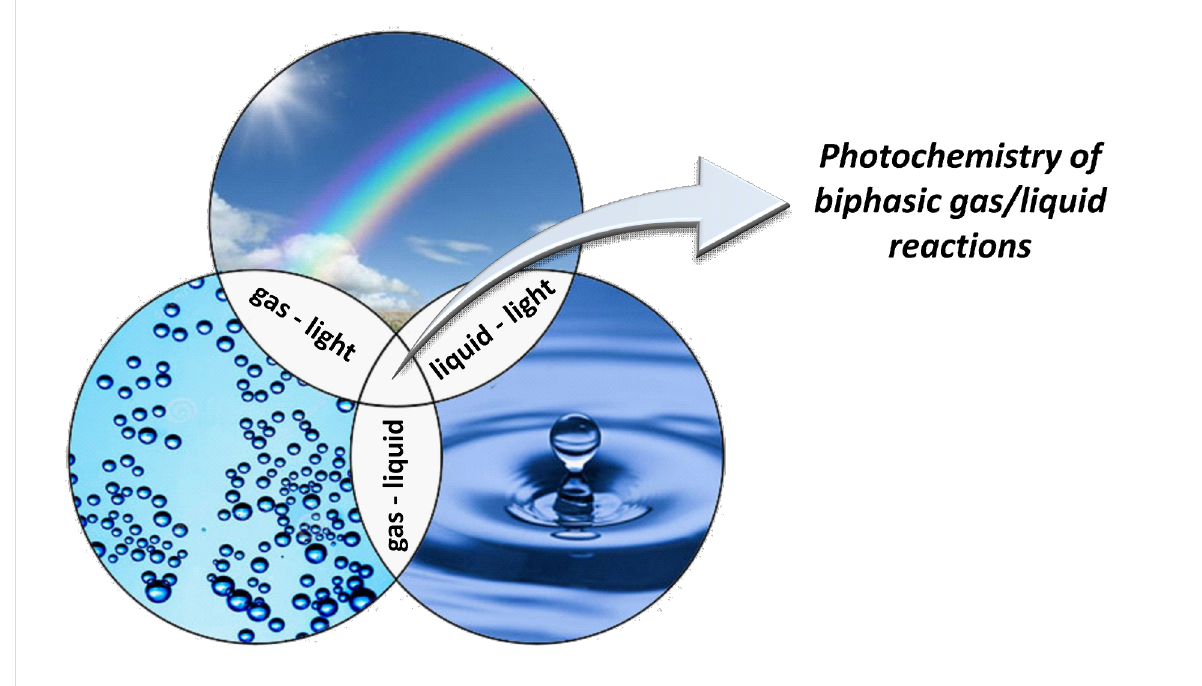
Figure 1: The challenge of mixing the three dispersed entities gas, liquid, and light for photochemical applications.